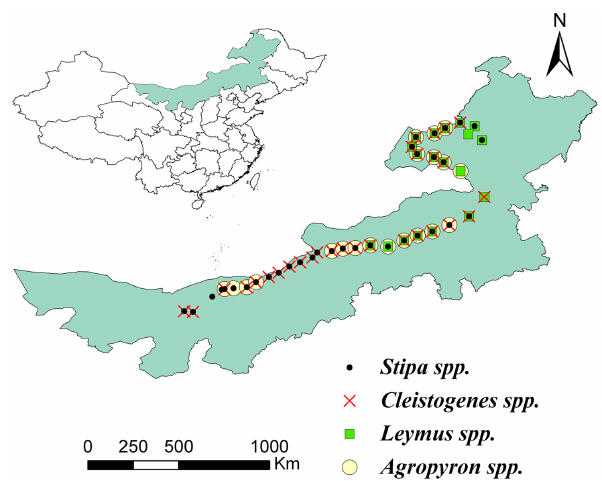
Figure 1. Locations of the sampling sites along the transect across the temperate grasslands of northern China.